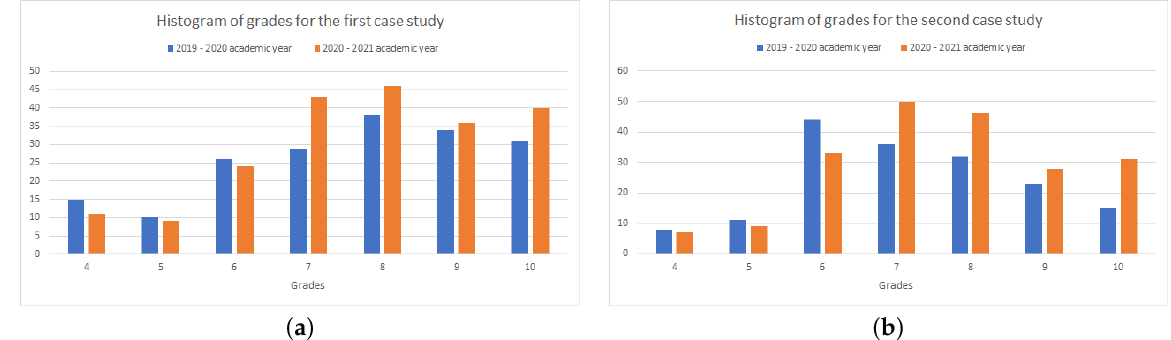
Figure 1. Histogram of grades for the first case study ( a ) and second case study ( b ).